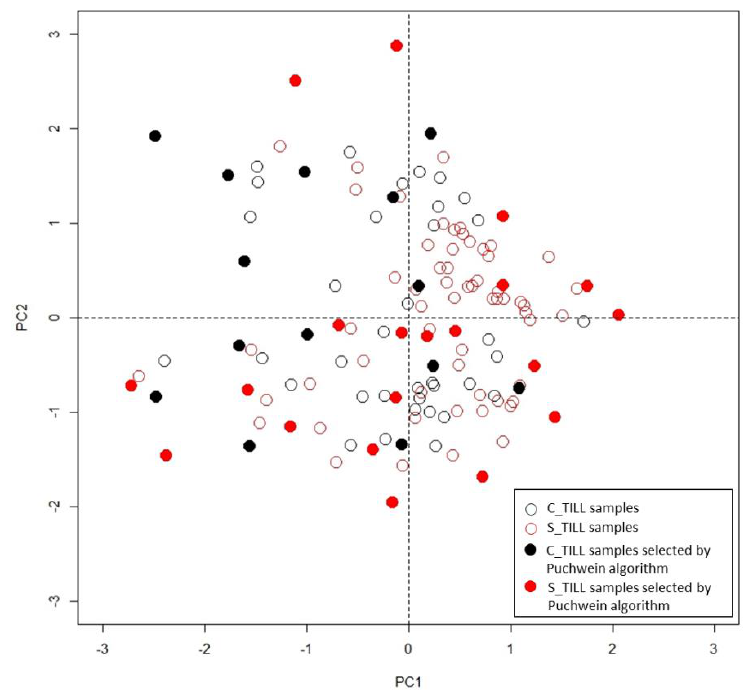
Figure 11. First principal component against second principal component scores of the Sentinel-2 spectra of the CAL dataset.